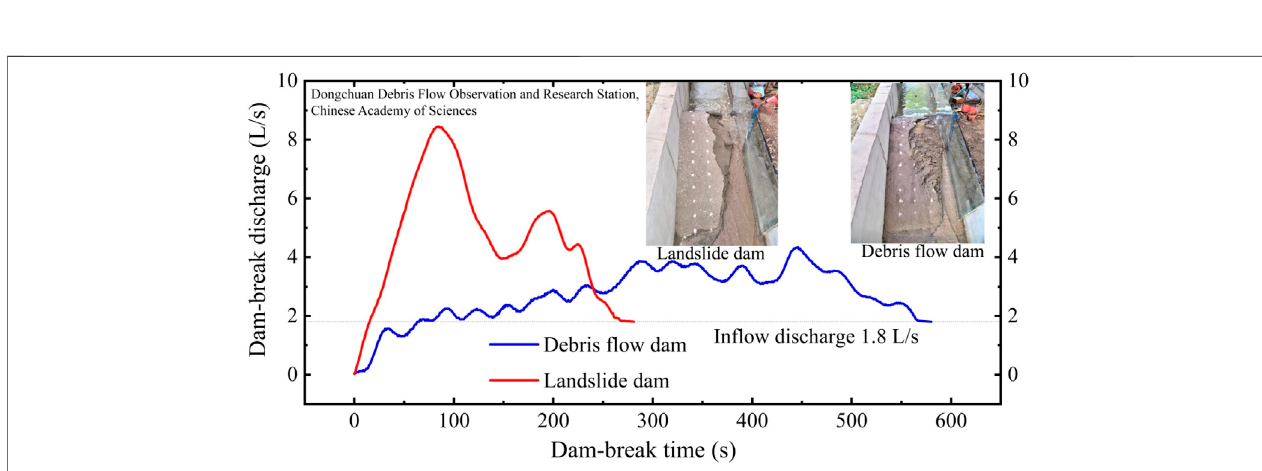
FIGURE 6 | Longitudinal evolution process of the debris- fl ow dam breach. (A,B) Formation stage of the retrogressive scarp (0 – 90 s); (B – D) Erosion stage of the retrogressive scarp (90 – 320 s); and (D,E) Decline stage of the retrogressive scarp (320 – 360 s) (Ruan et al., 2021).